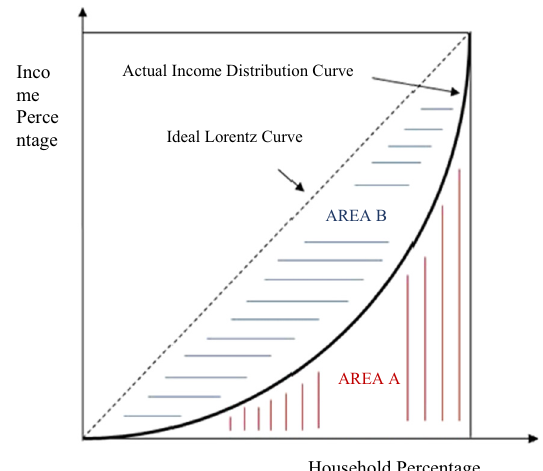
Figure 2: Income distribution in the